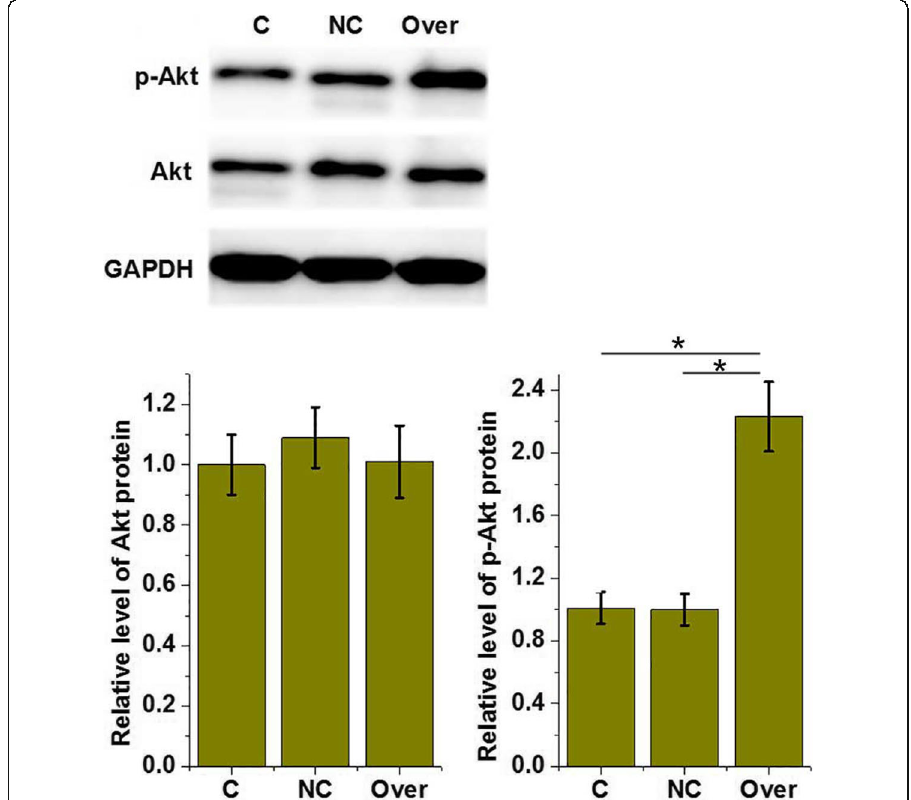
Fig. 3 The effects of lncRNA-ATB overexpression on the expression and phosphorylation of Akt in chondrocytes. * p <0.05. C, control; NC, negative control; Over, lncRNA-ATB overexpression. The expression and phosphorylation of Akt in chondrocytes after lncRNA-ATB overexpression was detected via western blot. LncRNA-ATB overexpression promoted the phosphorylation but not the expression of Akt